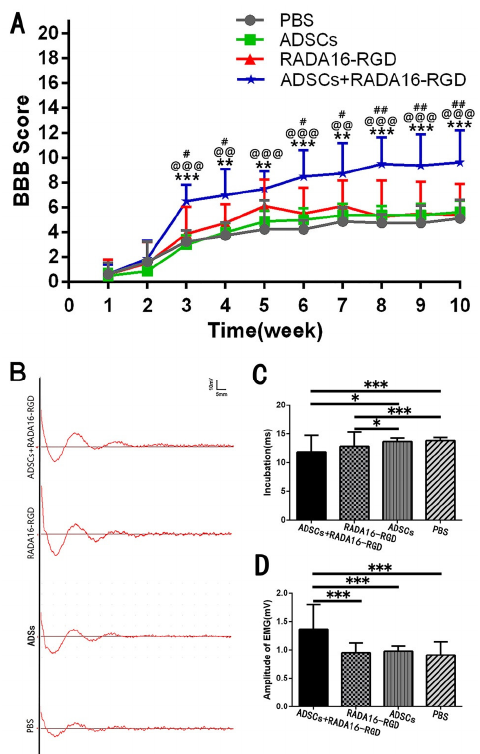
Figure 3. ADSCs+RADA16-RGD transplantation improves motor function in rats. ( A ) BBB scores for 10 consecutive weeks after spinal cord injury. At weeks 1 and 2, when compared with those for the RADA16-RGD group and PBS group, the BBB scores for the ADSCs+RADA16-RGD group showed no significant difference. From 3 to 10 weeks, the ADSCs+RADA16-RGD group’s BBB score increased significantly when compared with those of the PBS, ADSCs, and RADA16-RGD groups (ADSCs+RADA16-RGD vs. PBS: p < 0.01 after 4, 5, and 7 weeks, p < 0.001 after 3, 6, 8, 9, and 10 weeks; ADSCs+RADA16-RGD vs. ADSCs: p < 0.01 after 4 and 7 weeks, p < 0.001 after 3, 5, 6, 8, 9, and 10 weeks; ADSCs+RADA16-RGD vs. RADA16-RGD: p < 0.05 after 3, 4, 6, and 7 weeks, p < 0.01 after 8, 9, and 10 weeks). #ADSCs+RADA16-RGD vs. RADA16-RGD, @ ADSCs+RADA16-RGD vs. ADSCs, * ADSCs+RADA16-RGD vs. PBS. ( B ) MEP records at 8 weeks after transplantation. ( C ) Myoelectric detection indicated that the latency was shorter in the ADSCs+RADA16-RGD and RADA16-RGD groups than in the PBS and ADSCS groups (ADSCs+RADA16-RGD vs. RADA16-RGD: p < 0.001, ADSCs+RADA16-RGD vs. ADSCs: p < 0.05, RADA16-RGD vs. RADA16-RGD: p < 0.001, RADA16-RGD vs. ADSCs: p < 0.05). ( D ) The amplitude was significantly higher in the ADSCs+RADA16-RGD group than in the PBS, ADSCs, and RADA16-RGD groups (ADSCs+RADA16-RGD vs. PBS: p < 0.001, ADSCs+RADA16-RGD vs. ADSCs: p < 0.001, ADSCs+RADA16-RGD vs. RADA16-RGD: p < 0.001). Data are presented as mean ± SEM (BBB: n = 8 per groups, MEP: n = 4 per groups). # p < 0.05, ## p < 0.01, @@ p < 0.01, @@@ p < 0.001, ** p < 0.01, *** p < 0.001. Data are presented as mean ± SEM (BBB score n = 8 per group, MEP n = 4 per group). ADSCs: adipose stem cells; BBB: Basso, Beattie, and Bresnahan scale; MEP: motor-evoked potential; EMG: electromyogram. To verify the effect of ADSCs+RADA16-RGD on the functional recovery in the rats, electromyography was performed 8 weeks after transplantation for SCI. One side of the motor cortex was stimulated, and the electrical signal in the gastrocnemius muscle on the opposite side was assessed. The functional recovery of rats with SCI was evaluated based on the electromyography waveform and amplitude. Myoelectric detection was